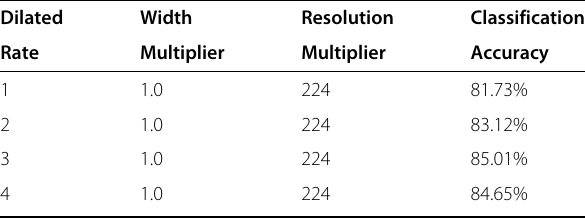
Table 6 Classification accuracy of different dilated rates in Tiny ImageNet